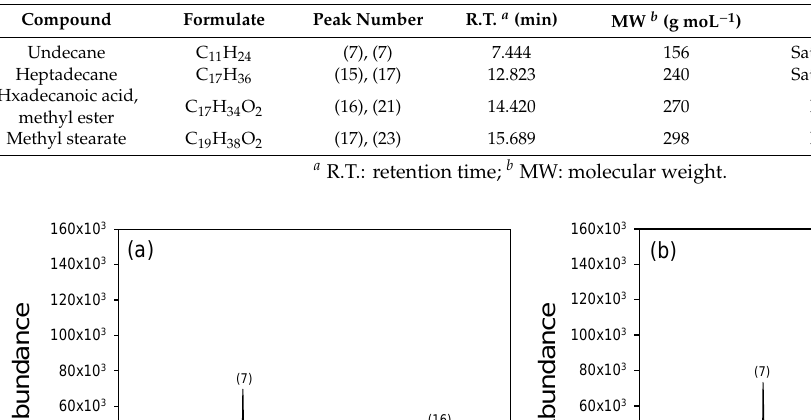
Table 4. Major chemicals of the harvested MB 2 and MB 3 samples identified from GC/MS analysis.